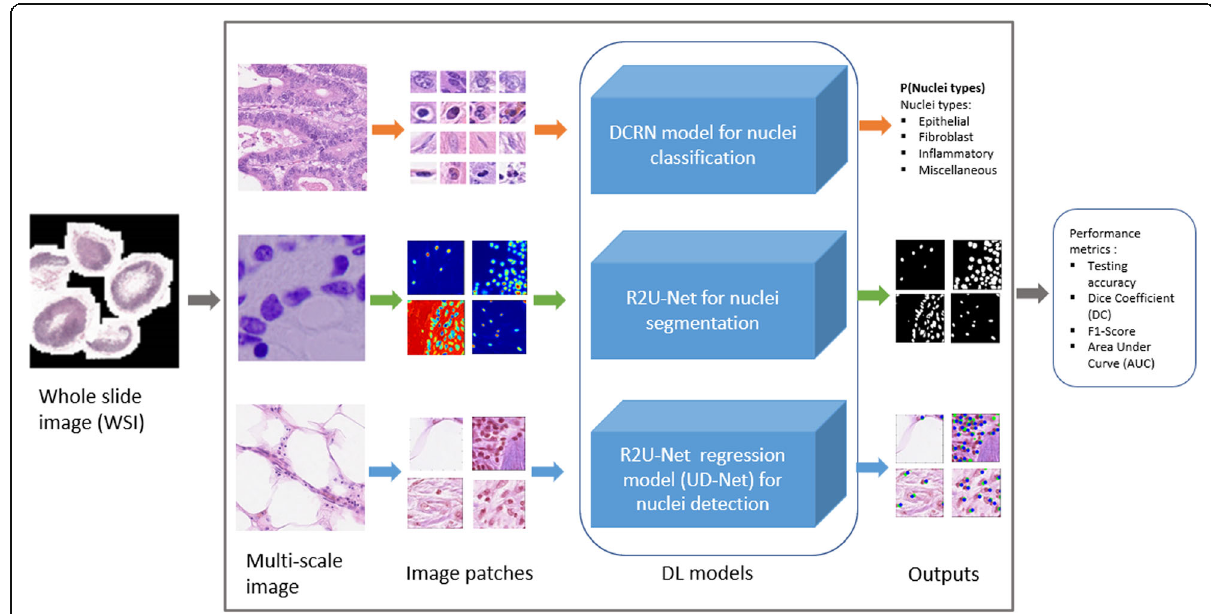
Fig. 1 Schematic diagram of the proposed systems: the patches are extracted from the multi-scale slide as required. Three different DL models are applied for nuclei classification, segmentation, and detection tasks. Finally, the performance is evaluated with different performance